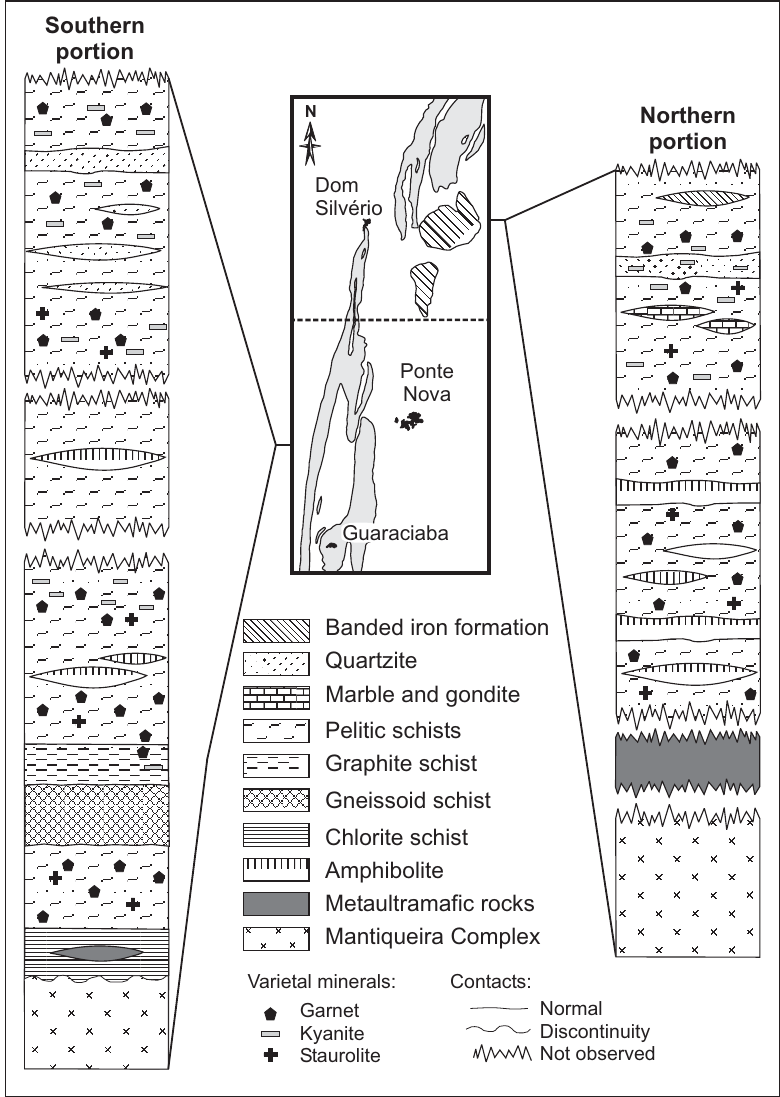
Fig. 5 – Vertical succession of the various rock types of the Dom Silvério Group in the northern and southern portions of the study area. Not in